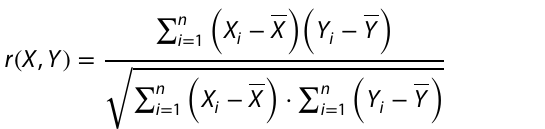
Fig. 6 Stress–strain master curves of 1.4113, AlMg5 and Cu99